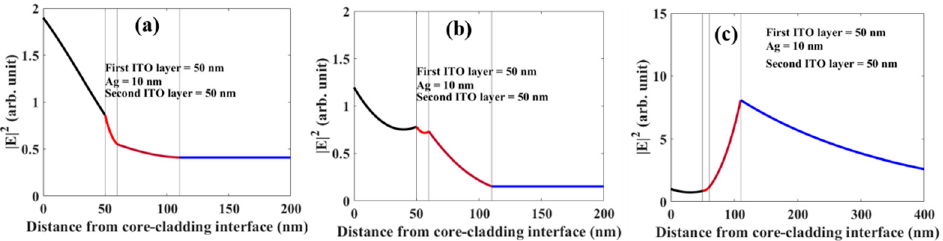
Figure 17. Electric field distribution corresponding to ( a ) first LMR ( b ) second LMR ( c ) SPR at their respective resonance wavelength at 631, 995, and 1798 nm respectively for probe configuration ITO (50 nm) +Ag (10 nm) +ITO (50 nm).